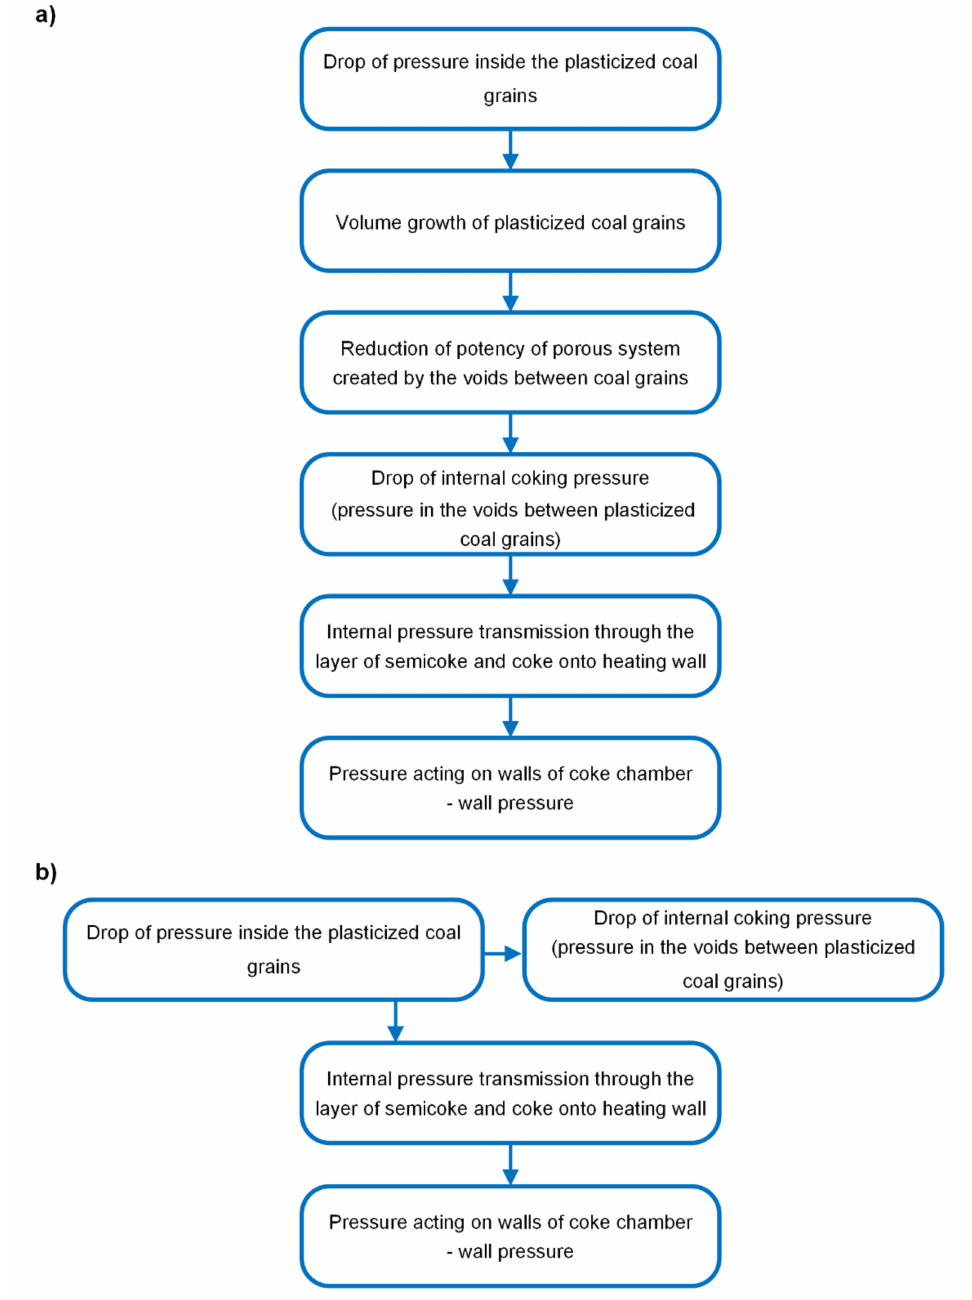
Figure 1. Mechanism of coking pressure generation by the plastic layer: ( a ) hypothesis of limited gas permeability of the plastic layer as the direct source of the wall pressure; ( b ) hypothesis of plasticized coal grains swelling under conditions of limited expansion as the direct source of the wall